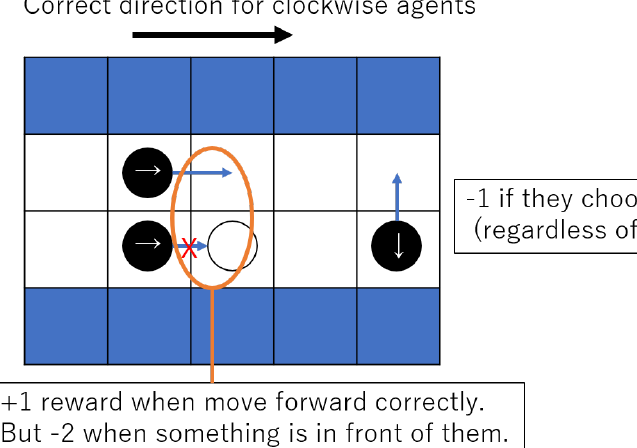
Figure 3. Agents’ rewarded situation.